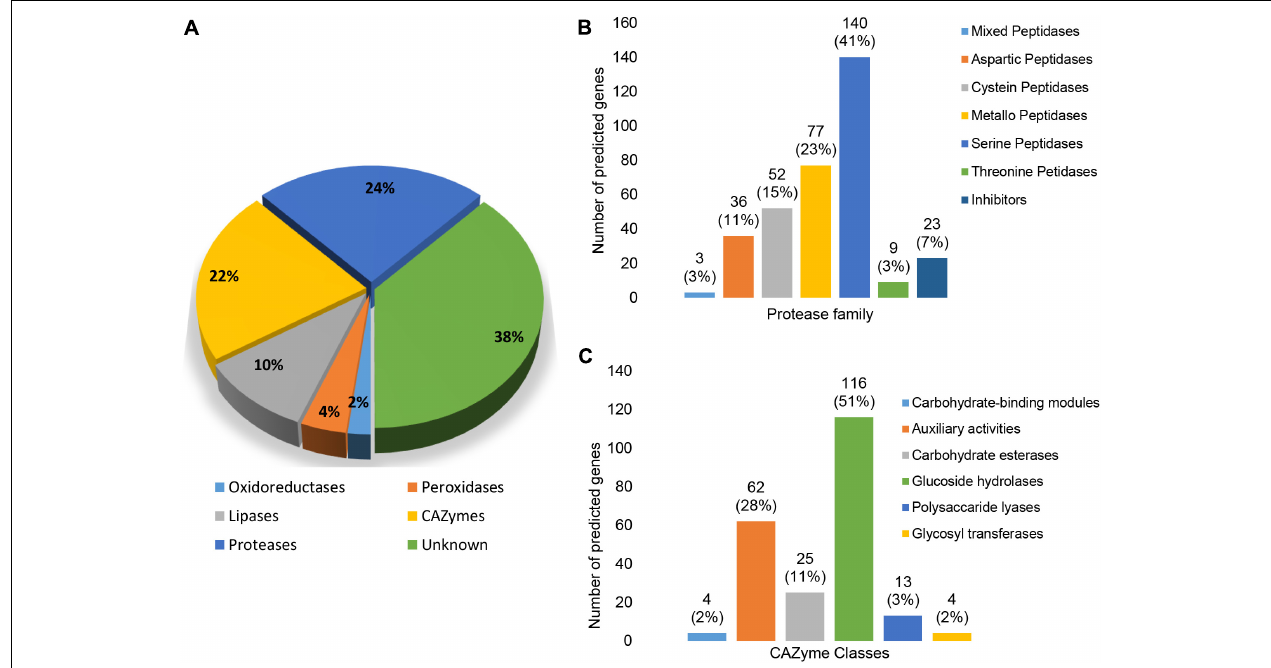
FIGURE 5 | (A) Predicted enzyme composition of the N. psidii MA3 secretome. (B) Representation of protease families in the predicted secretome. (C) Representation of CAZyme families in the predicted